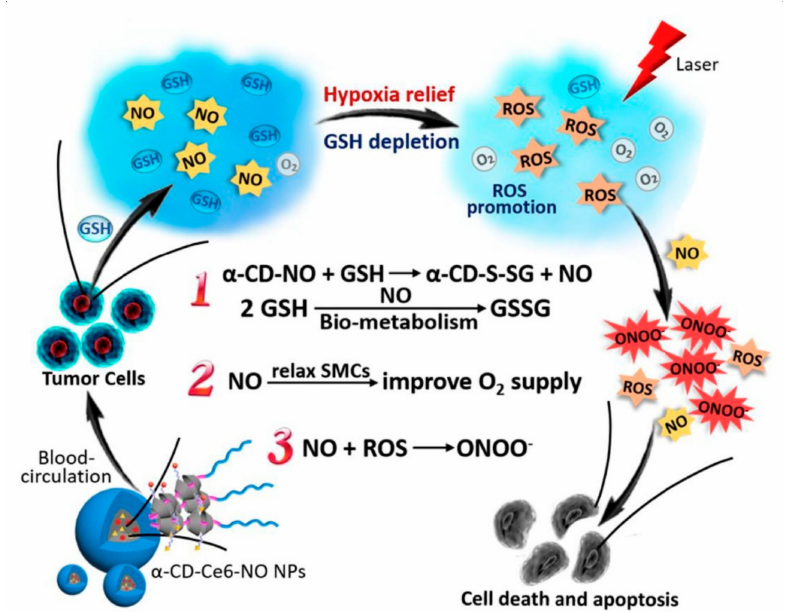
Figure 4. Schematic representation of multiple synergistic effects between PDT and nitric oxide (NO) generated from the nanoparticles α -cyclodextrin-chlorin e6-NO ( α -CD-Ce6-NO) nanoparticles (NPs) improves anticancer efficacy. Reproduced with permission from Elsevier. Source: